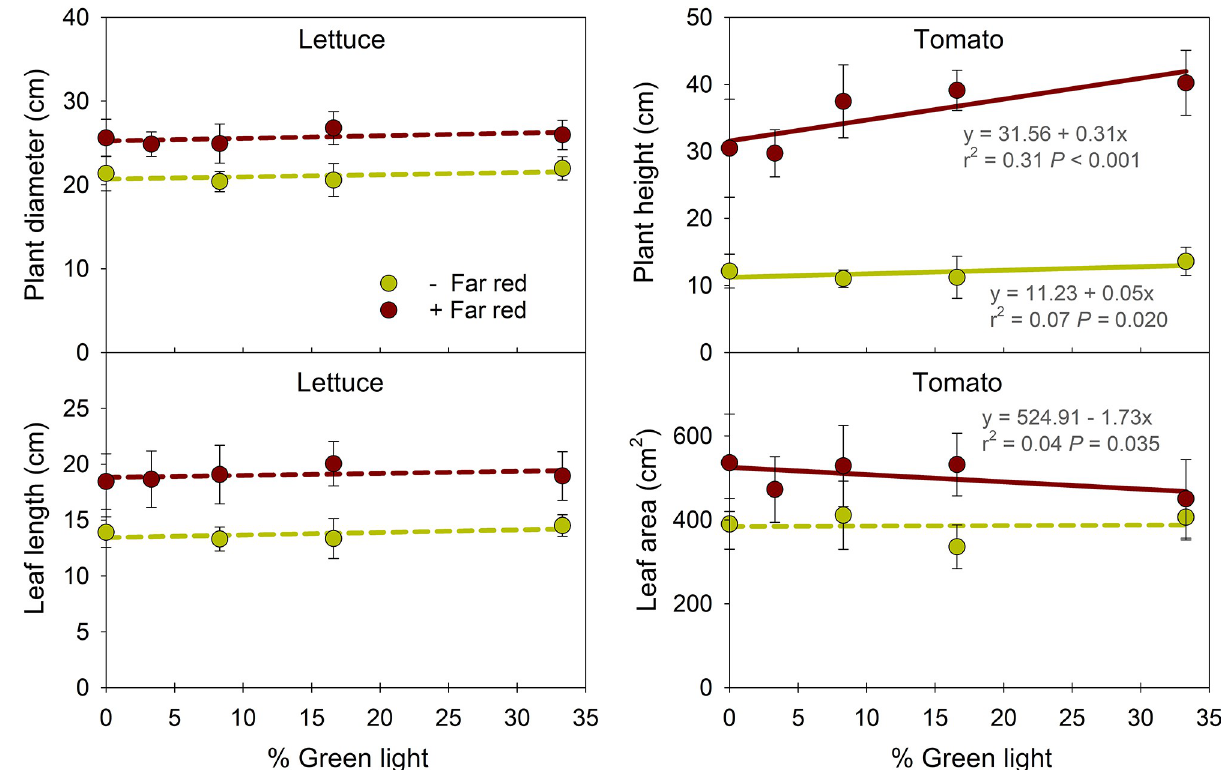
Fig 2. Influence of percentage of green light on plant diameter and leaf length of the fifth-most mature leaf of lettuce ‘Cherokee’ and plant height and leaf area of tomato ‘Bamborange’ with (+) and without (-) far-red light. See Fig 1 and Table 1 for information on the lighting treatments. Each data point represents the mean and standard deviation of two replications with 10 subsamples (plants) per replication and species (n = 20). Regression equations, r 2 values, and P values are presented when statistically significant (solid line) but not when non-significant (dashed